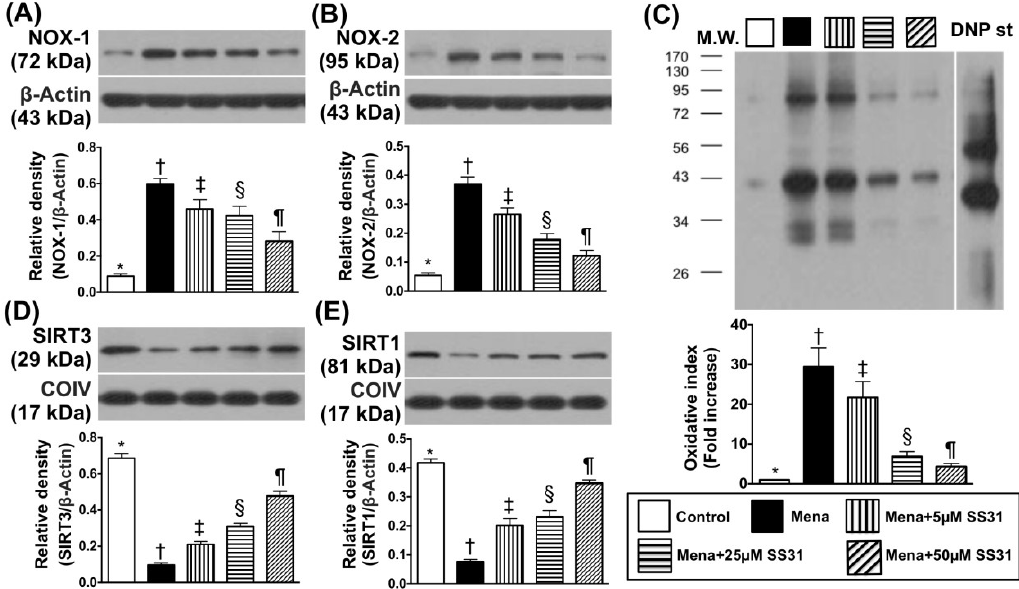
Figure 1. SS31 inhibits menadione-induced oxidative stress in H9C2 cells. ( A ) Protein expression of NOX-1 * vs. other groups with different symbols (†, ‡, §, ¶), p < 0.0001. ( B ) Protein expression of NOX-2 * vs. other groups with different symbols (†, ‡, §, ¶), p < 0.0001. ( C ) Oxidized protein expression * vs. other groups with different symbols (†, ‡, §, ¶), p < 0.0001. (Note: left and right lanes shown on the upper panel represent a protein molecular weight marker and control oxidized molecular protein standard, respectively). M.W = molecular weight. DNP = 1-3 dinitrophenylhydrazone. ( D ) Protein expression of mitochondrial SIRT3 * vs. other groups with different symbols (†, ‡, §, ¶), p < 0.0001. ( E ) Protein expression of mitochondrial SIRT1 * vs. other groups with different symbols (†, ‡, §, ¶), p < 0.0001. All statistical analyses were performed by one-way ANOVA and followed by the Bonferroni multiple comparison post hoc test ( n = 6 for each group). Symbols (*, †, ‡, §, ¶) indicate significance at the 0.05 level.